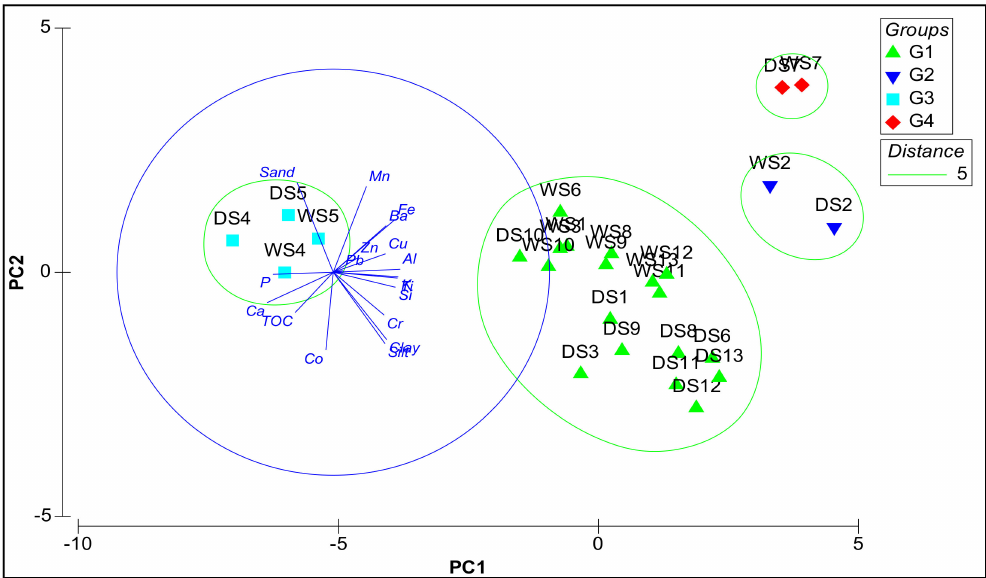
Figure 3. Principal component analysis (PCA) of the wet and dry seasons (WS, wet station and DS, dry station) for the geochemical parameters, granulometry, and